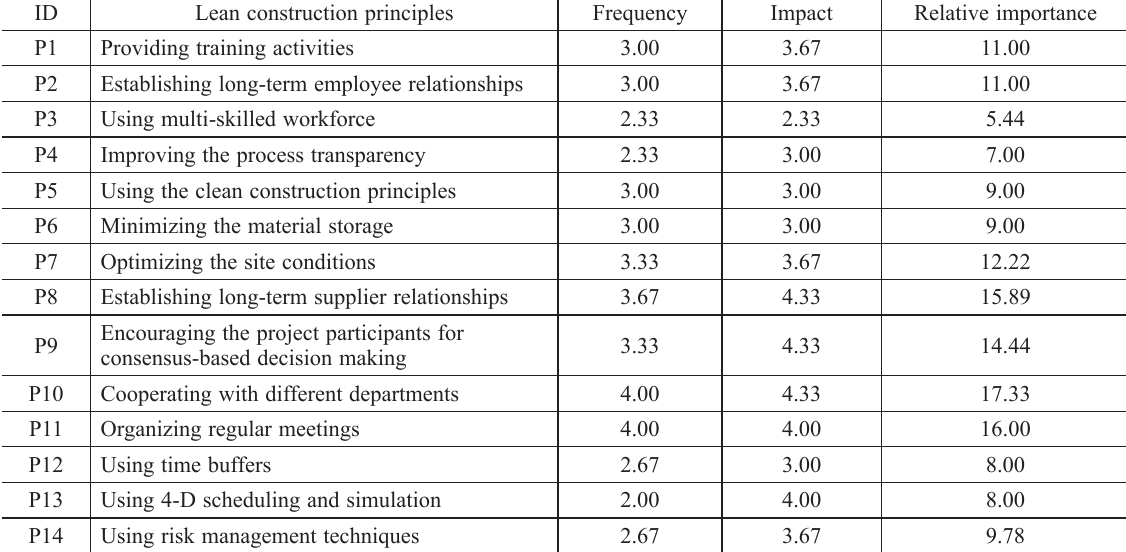
Table 5. Relative importance of the lean construction principles